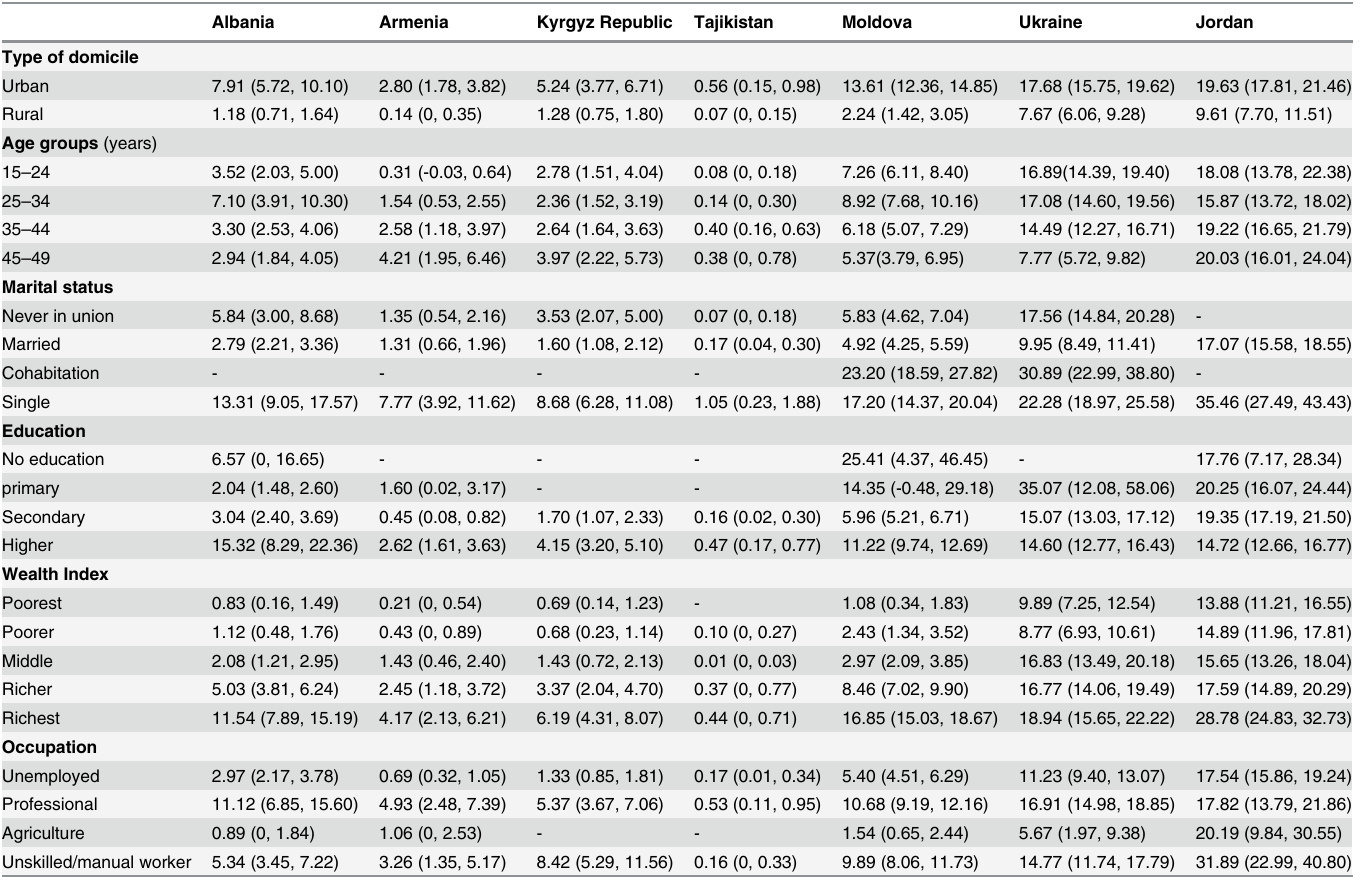
Table 4. Weighted prevalence estimates (%) and 95% CIs of smoking by social factors among women in 7 countries (North Africa, Central and West